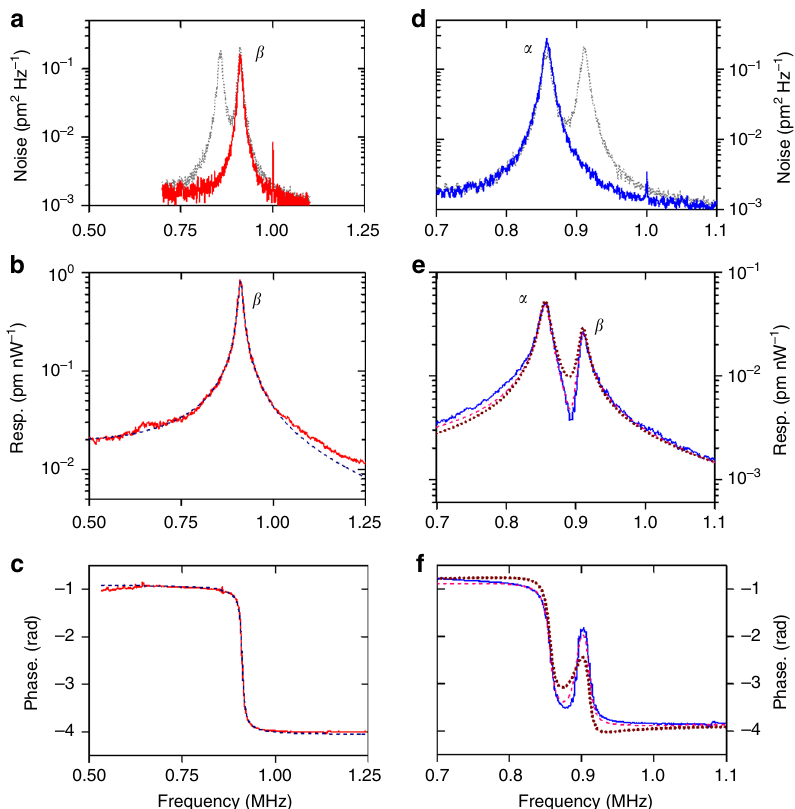
Fig. 4 Experimental data and modelling. a Radio frequency (RF) spectrum with near-infrared (NIR) detection optimized on the β resonance (red curve). The dotted curve reproduces the spectrum from Fig. 2a. b , c Lock-in ampli fi er amplitude ( b ) and phase ( c ) measured in this condition (continuous curve). The dashed curves are computed from Eq. (4). d RF spectrum with NIR detection optimized on the α resonance (blue curve). e , f Corresponding amplitude ( e ) and phase ( f ) (continuous curves). Dotted curves: fi t assuming that the force acting on the α resonance is described by Eq. (2), while the force acting on the β resonance is described by Eq. (4). Dashed curves: fi t including a photothermal contribution to the optomechanical force acting on